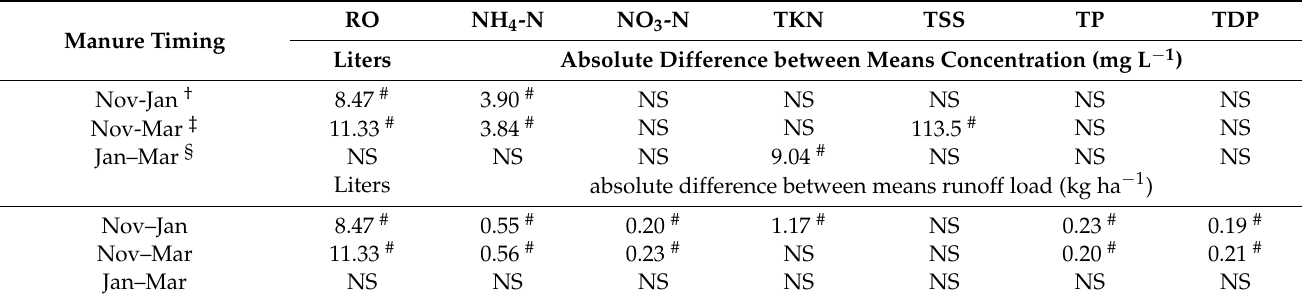
Table 6. Mean difference comparisons of several runoff concentrations and loss parameters from manure timing treat- ments;